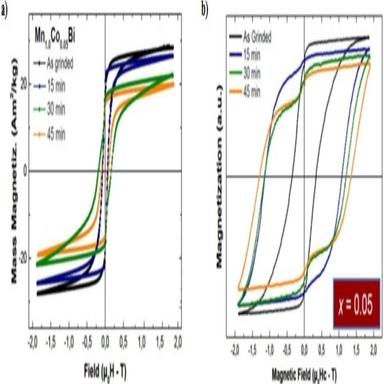
.a) Hysteresis loops of Mn1Co0.05Bi powder for various ball milling times, from 0 to 45 min, b) Hysteresis loops of the same orientated samples.